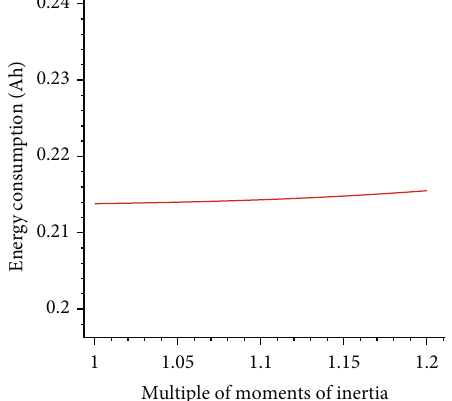
Multiple of moments of inertia Figure 34: The energy consumption of the Quad-Plane with the di ff erent moment of inertia under 5.6 m/s wind disturbance in the 30